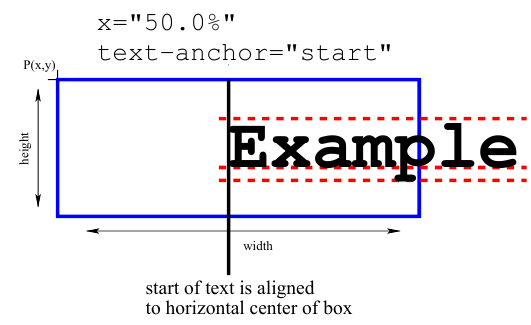
Figure 21: horizontal text alignment start